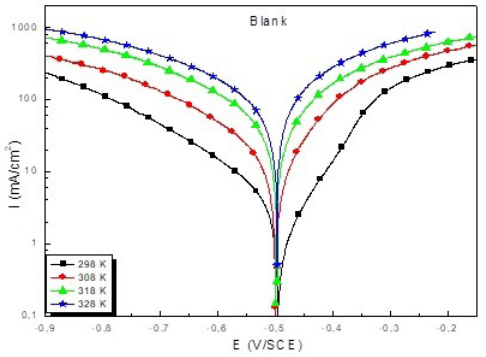
Figure 5. Potentiodynamic polarization curves for ordinary mild steel 5.0 M HCl solution in the absence of inhibitors at different temperatures range.